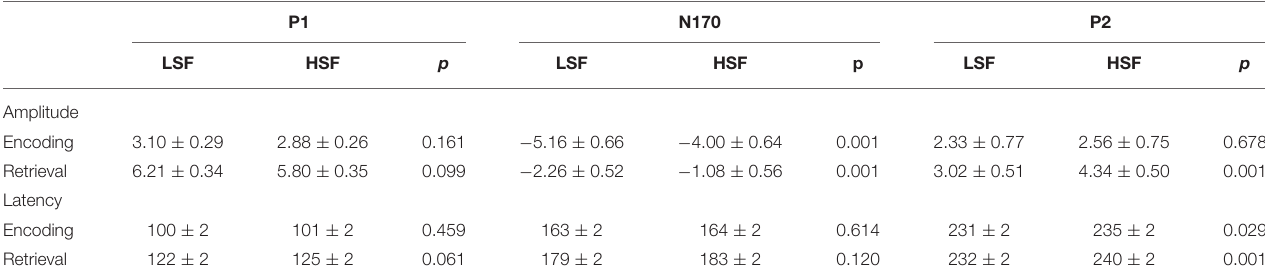
TABLE 1 | The amplitude ( µ V) and latency (ms) values of the P1, N1, and P2 components for low-spatial frequency (LSF) and high-spatial frequency (HSF) face during the encoding and retrieval stages. P1 N170 P2 HSF p